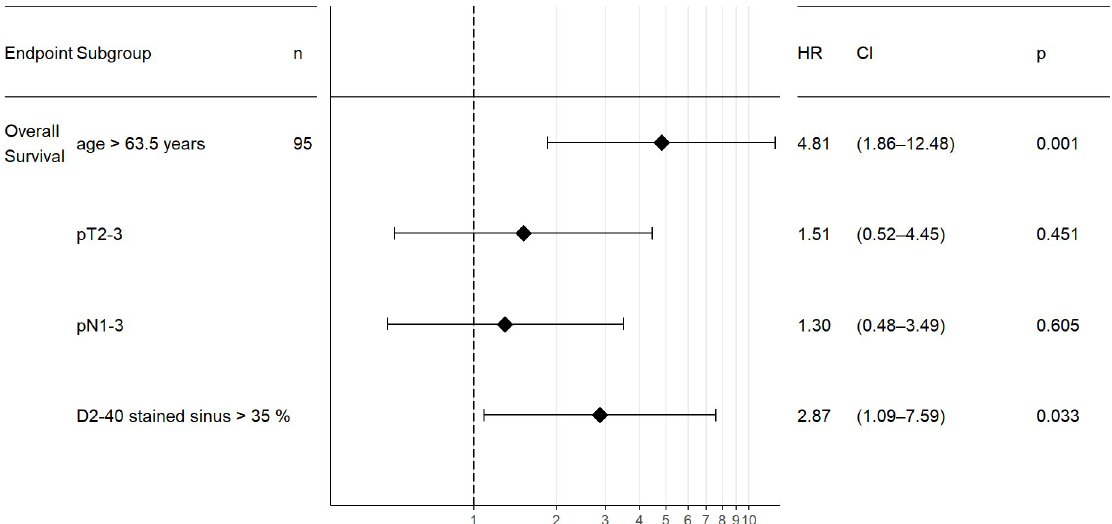
Fig 7. Forest plot for the multivariate analysis for older age at surgery, higher pT stage, positive nodal status and proportion of D2-40 stained sinus in SLN with respect to overall survival. The Cox regression hazard ratio (HR), 95% confidence interval (CI) and p values are plotted with respect to overall survival for older patients (“age > 63.5 years”) vs. younger patients, higher pT stage (“pT2-3”) vs. pT1), positive nodal status (“pN1-3”) vs. negative nodal status and higher proportion of D2-40 stained sinus in SLN (“D2-40 stained sinus > 35%”) vs. lower proportion of D2-40 stained sinus in SLN. Higher proportion of D2-40 stained sinus in SLN is an independent prognostic parameter for worse overall survival in multivariate